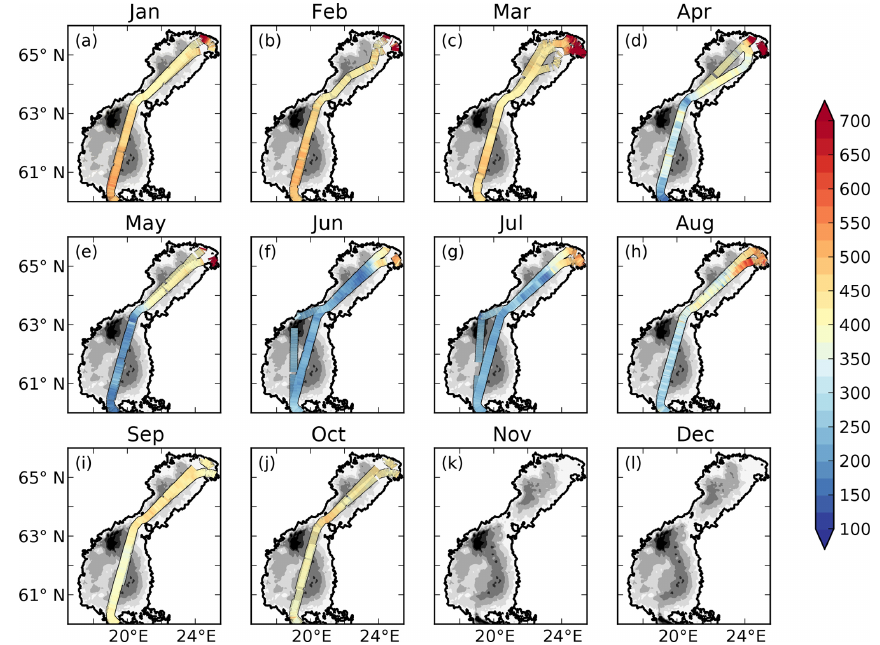
Figure 2. Observed (filled lines) p CO 2 (µatm) and cargo route for each month. The filled contours show the bathymetry of the model. Table 1. Experimental